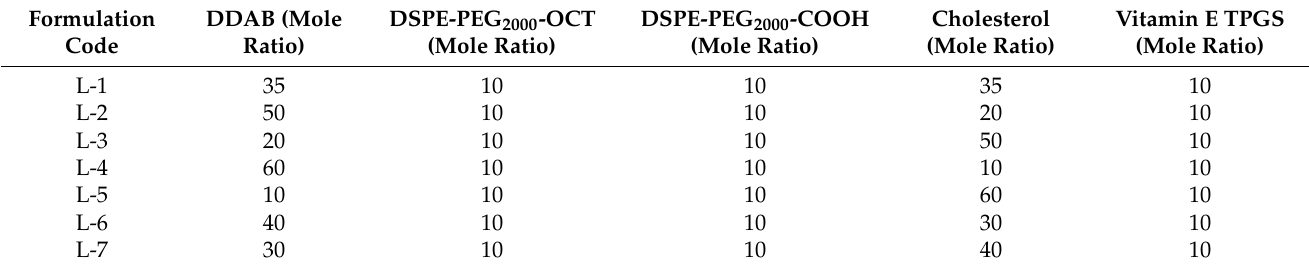
Table 1. OCT-Lcn2-Lipo formulation